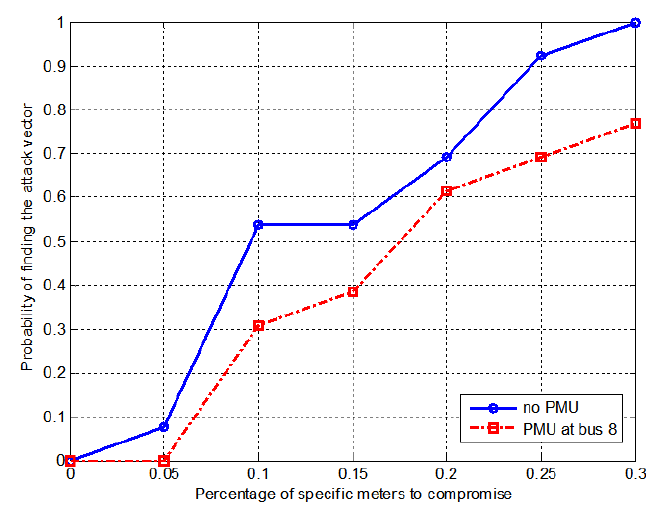
Figure 4. Probability of finding the attack vector in IEEE 14-bus system.